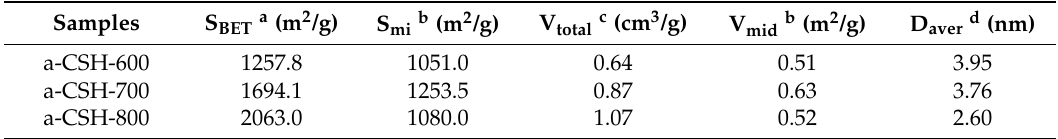
Table 1. Pore characteristics of the a-CSHs samples.